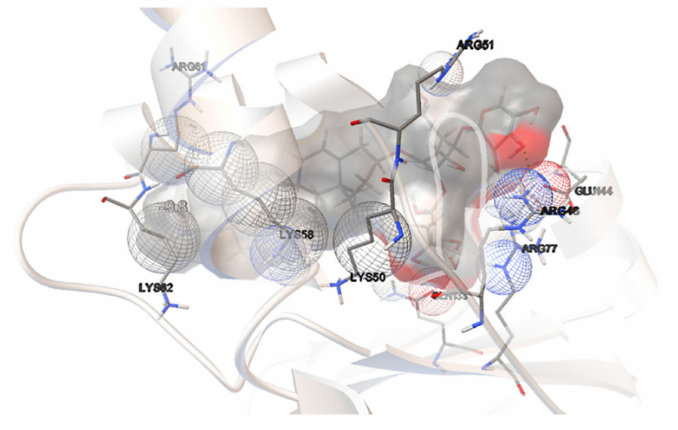
Figure 8. Dioscin interactions with the binding pocket of a SpoT protein of H. pylori